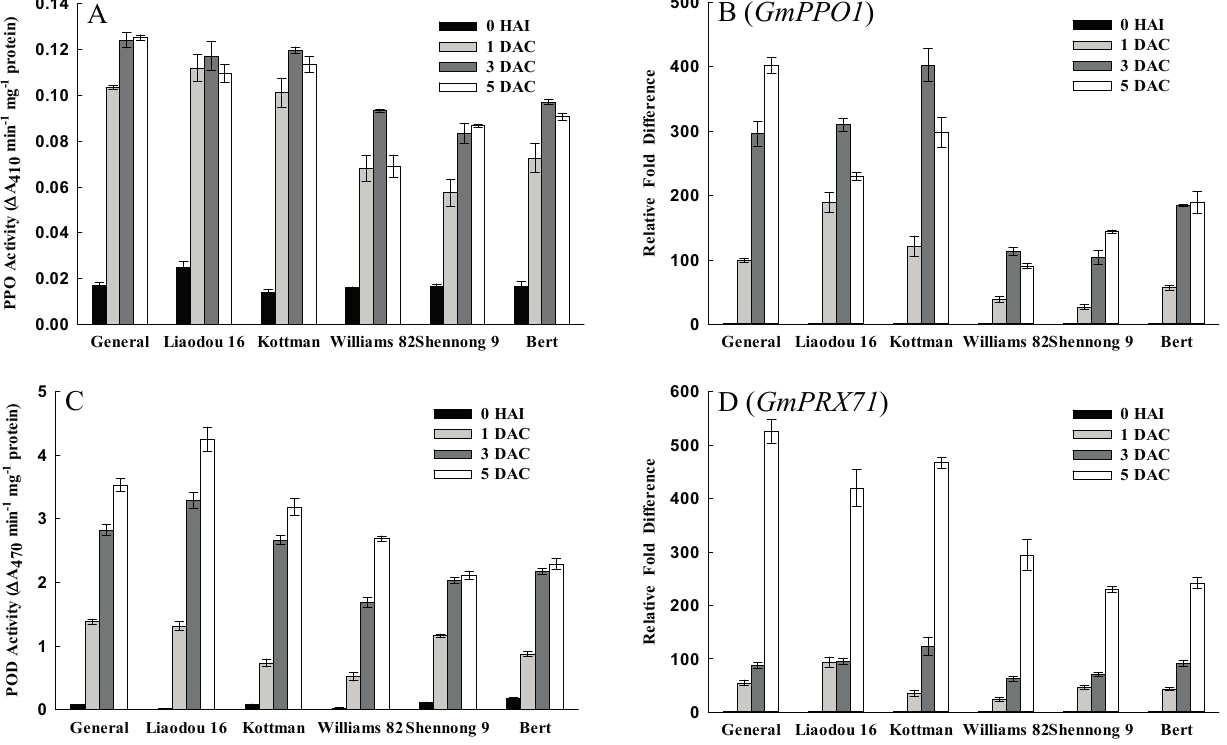
Figure 8. Comparison of polyphenol oxidase (PPO) and peroxidase (POD) activity, and the expression of encoding genes between different genotypes. The values represent means ± SD based on three biological replications. ( A ) PPO activity in cotyledonary nodes after 0 h of infection, and after one day, three days, and five days of co-cultivation; ( B ) qRT-PCR analysis of the gene GmPPO1 that encodes PPO; ( C ) POD activity; and ( D ) qRT-PCR analysis of the gene GmPRX71 that encodes